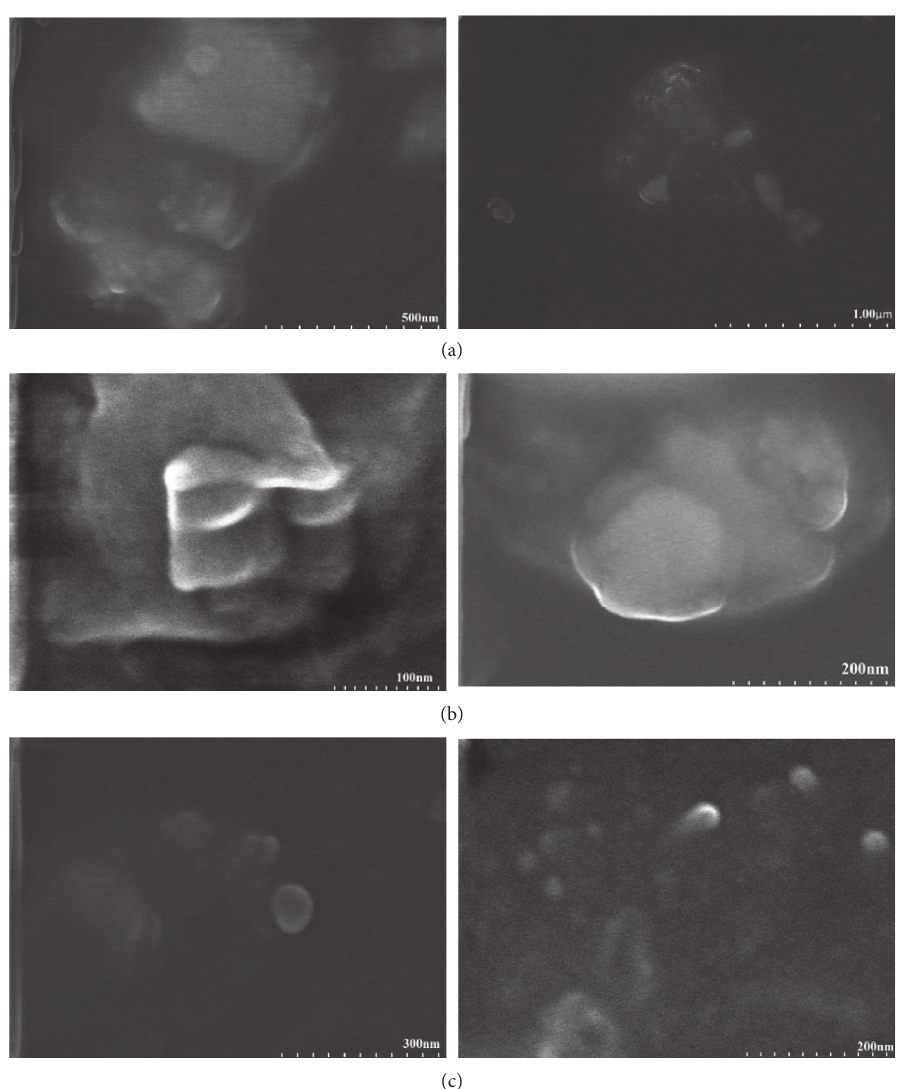
Figure 10: FE-SEM of chitosan/TPP at the ratios: (a) chitosan/TPP � 8/2; (b) chitosan/TPP � 4/2; (c) chitosan/TPP �